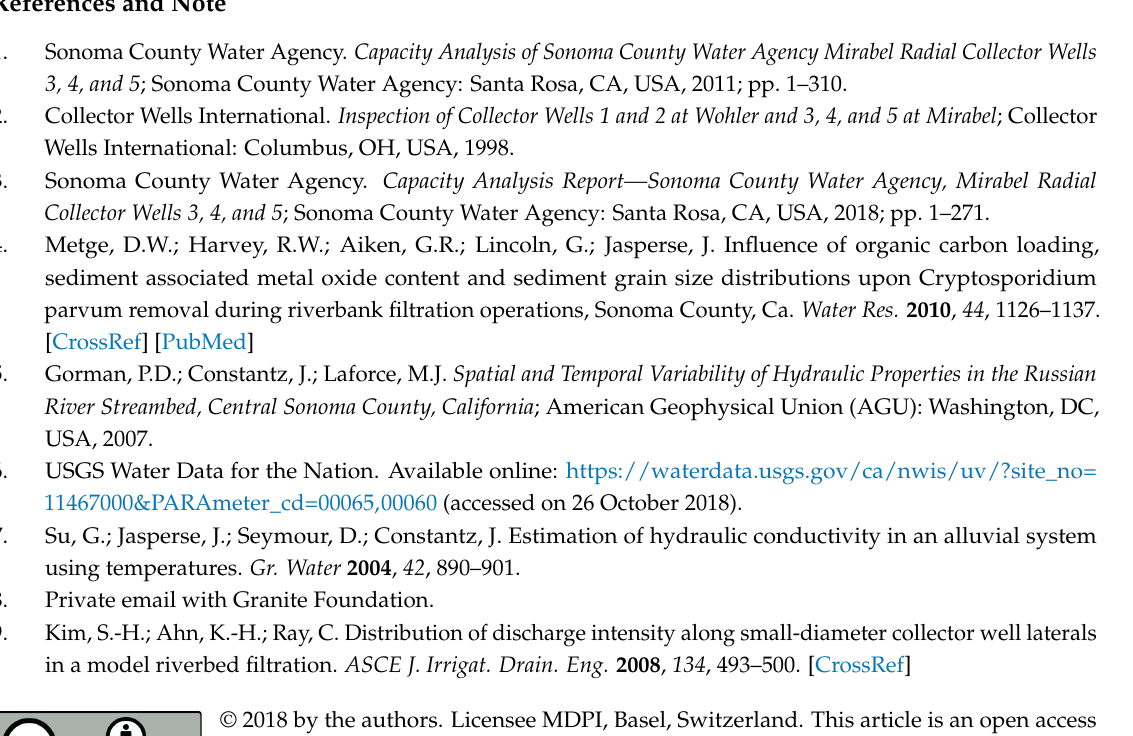
Figure S6: Collector Well 6, Lateral 4: 10 ft (3.048 m) progression from the lateral video inspection, 2008 (Source: Sonoma County Water Agency). Table S1: Summary of collector wells and construction parameters. Table S2: Summary of laterals’ construction